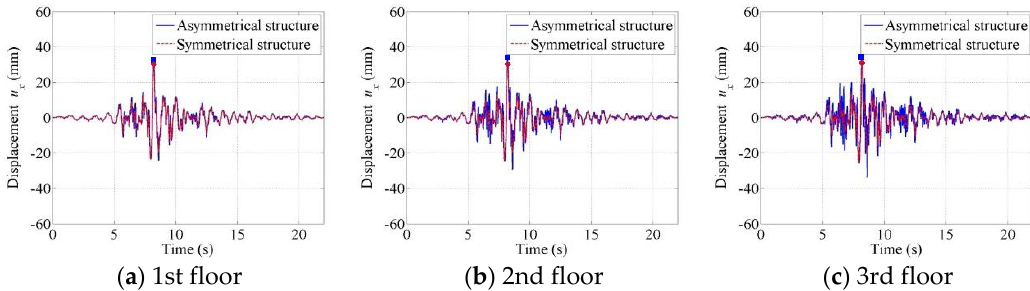
Figure 36. Displacement responses of the asymmetric SMART 2013 structure and the hypothetical symmetric structure due to the Northridge earthquake (Run 19); Responses sampled at point D.